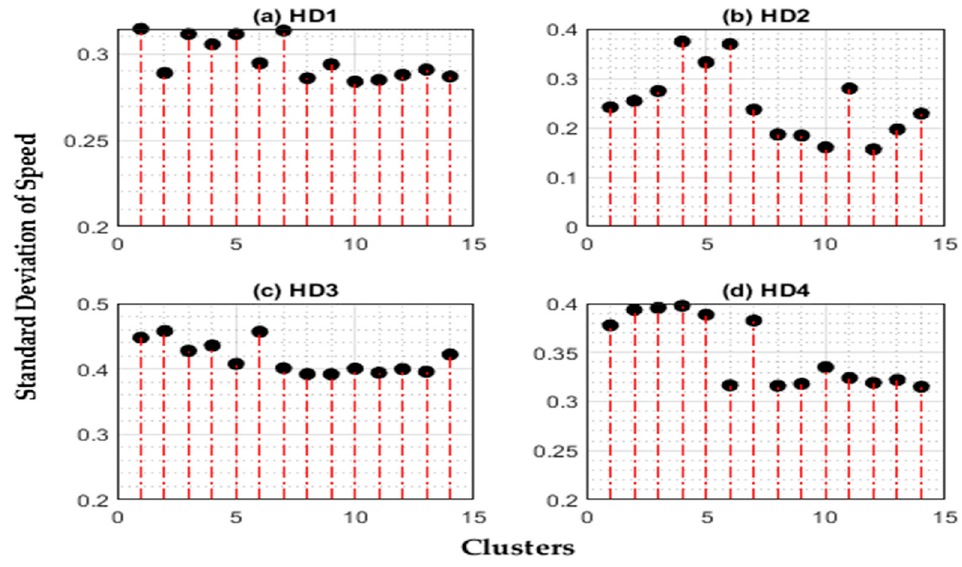
Figure 17. RK-Means standard deviation of speed in high-density scenarios. Table 11shows the comparison of the standard deviations of RK-Means, K-Means++, and OK-Means in both scenarios. The small value of the standard deviation in the proposed model indicates that the cluster lifetime was high, because all vehicle locations changed within a small duration. The new clusters contained the same vehicles, so the cluster member changing rate was low. Table 11. The standard deviation of speed numerical